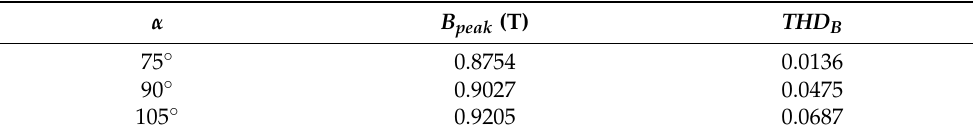
Figure 7. Distribution diagram of air gap magnetic field ( α = 105 ◦ ): ( a ) distribution cloud diagram of |B| and ( b ) localized view of magnetic induction vector B . Table 4. Calculation results of the B peak and THD B of the central magnetic field in the air